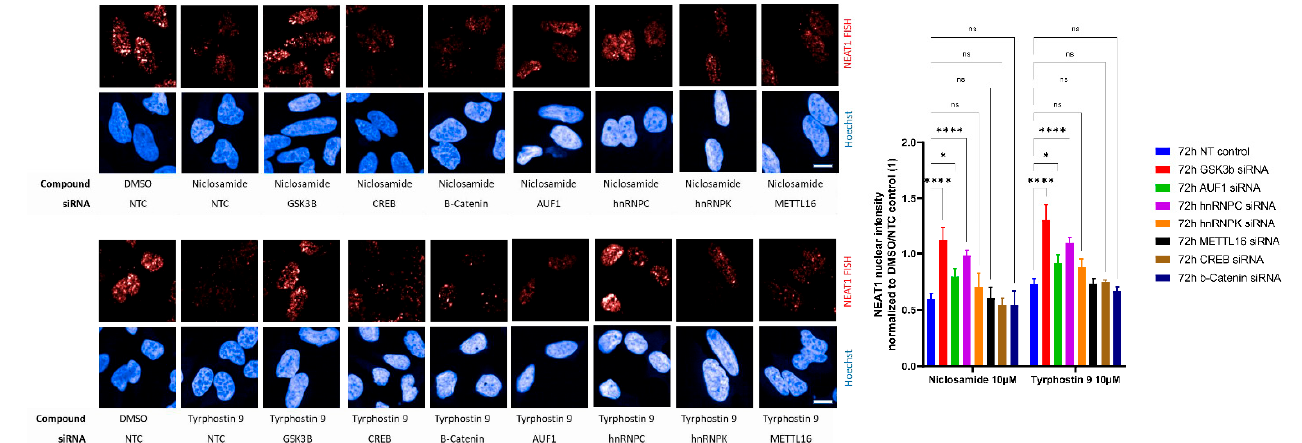
Figure 7. Hela stained for NEAT1 lncRNA by fluorescence in-situ hybridization after 72 h siRNA against the indicated target followed by 2 h treatment with DMSO control or HTS hits at 10 µ M. Nuclei are stained by Hoechst. Scale bar ~10 µ m. Quantification of nuclear NEAT1 staining after siRNA and compound treatment. GSK3B and hnRNPC knockdown significantly prevent compound induced reduction of nuclear NEAT1 staining intensity. Bars show mean with SD. **** p value < 0.0001; * p value < 0.1; ns = not significant.